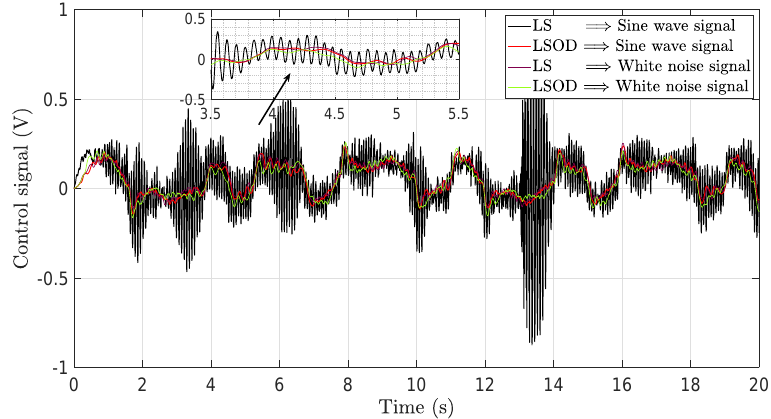
Figure 13. Control signals produced by control law (62) with the parameter estimate β ∗